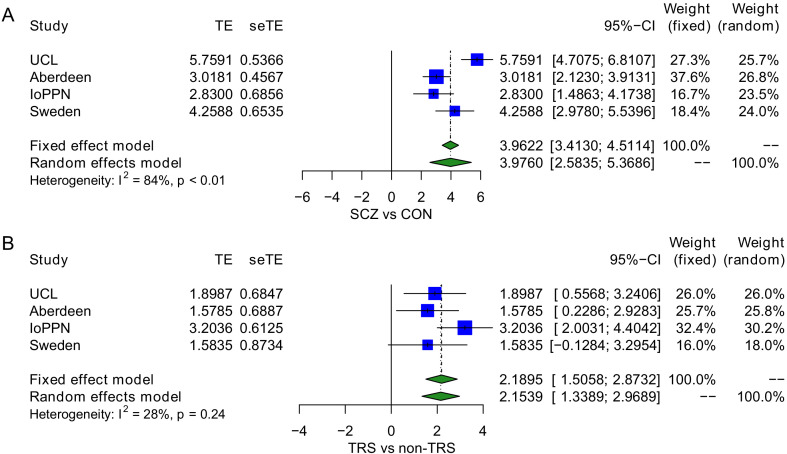
Treatment-resistant schizophrenia (TRS) patients show an elevated exposure to tobacco smoking relative to non-TRS and controls in a model testing both schizophrenia diagnosis status and TRS status simultaneously.(A) Schizophrenia diagnosis was associated with a significant increase in smoking score (mean difference = 3.98; p=2.19×10-8) with (B) TRS status associated with an additional increase within cases (mean difference = 2.15; p=2.22×10-7). TE: treatment effect (i.e., the mean difference between cases and controls); seTE: standard error of the treatment effect.